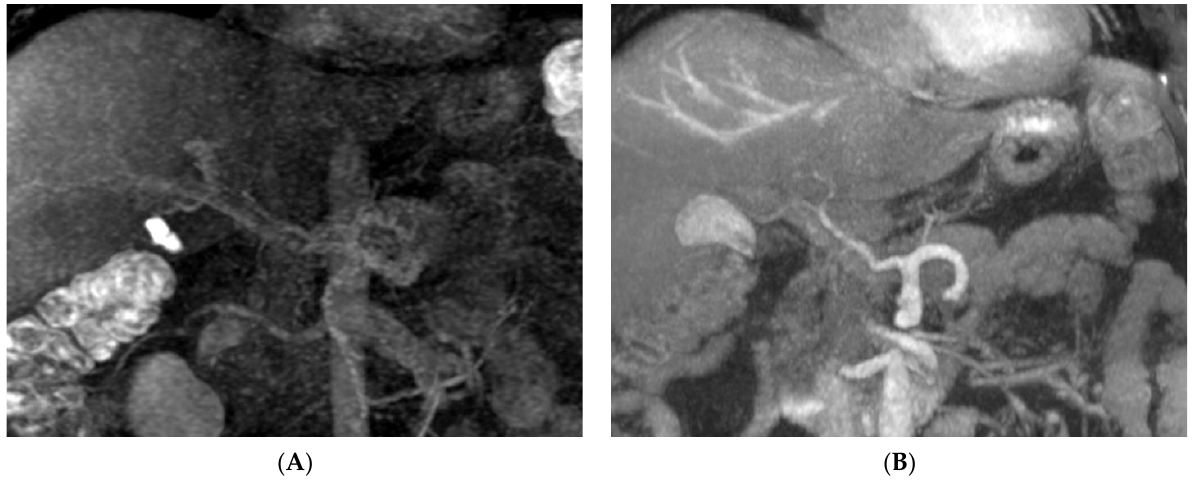
Figure 3. Non-CE MRA is an alternative way of acquiring vascular image. A 45-year-old male donor candidate has suboptimal hepatic artery image in CMRA ( A ). The non-CE MRA ( B ) provides diagnosable delineation of hepatic artery pattern.